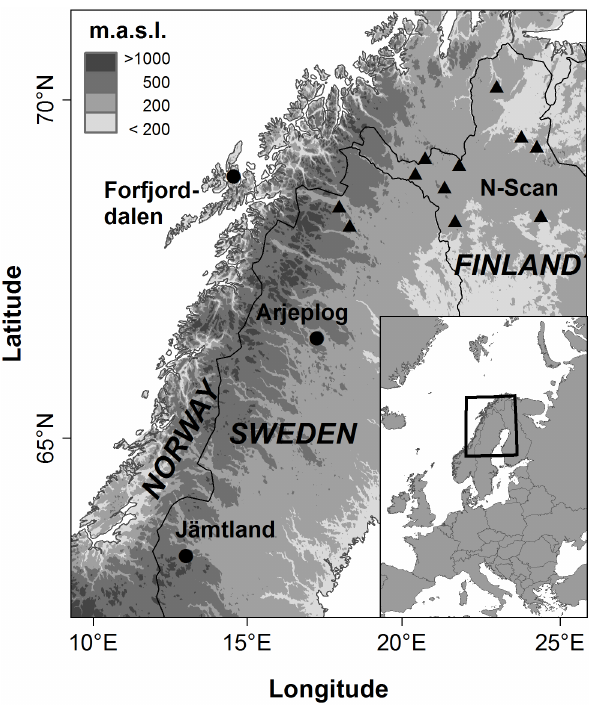
Fig. 3. Filled circles indicate the Arjeplog site produced for this study, as well as Jämtland (Gunnarson et al., 2011) and Forfjord- dalen (McCarroll et al., 2013). Triangles are the sub-sites included in the N-Scan chronology (Esper et al., 2012a). Jämtland, Forfjord- dalen and N-Scan are used as reference chronologies in this study.